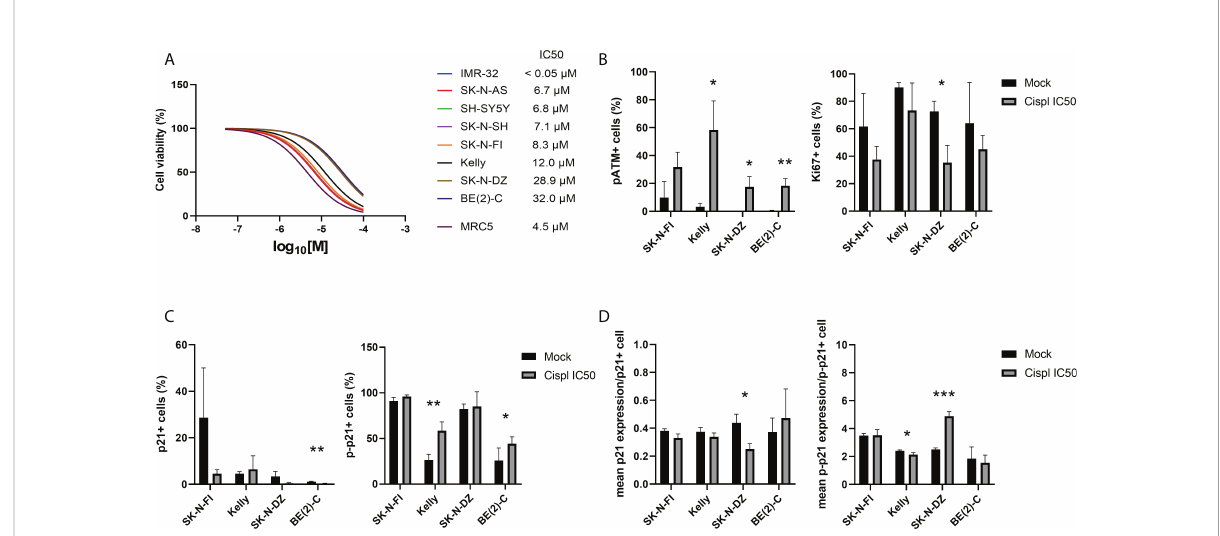
FIGURE 3 Immuno fl uorescence staining of p21, p-p21, pATM, and Ki67 in NB cell lines following treatment with cisplatin. (A) Dose – response curves for cell viability after 72 hours of cisplatin treatment in eight NB cell lines and the fi broblast cell line, MRC5. Cell viability was assessed using MTS-assay to determine the IC 50 values of cisplatin as a single agent. Concentration ranges, from 100 µM to 0.05 µM of cisplatin, was added. TP53 wt cell lines were in general more sensitive compared to the TP53 mut cell lines. n=3. (B) Analyzing the fraction of either pATM or Ki67 single positive cells following treatment with cisplatin for 24 hours at the corresponding IC 50 concentration for each of the cell lines. The fraction of pATM was increased in three out offour cell lines, and SK-N-DZ showed a reduction in the fraction of Ki67 positive cells following treatment. * = p<0.05, ** = p<0.01, not signi fi cant p>0.05, Student´s t-test. Mean ± SD, n=3. (C) Analyzing the fraction of either p21 or p-p21 single positive cells following treatment with cisplatin for 24 hours at the corresponding IC 50 concentration for each of the cell lines. BE(2)-C showed a decrease in the fraction of p21 positive cells, whereas Kelly and BE(2)-C showed an increase in the fraction of p-p21 positive cell. * = p<0.05, ** = p<0.01, not signi fi cant p>0.05, Student´s t-test. Mean ± SD, n=3-6. (D) Analyzing the mean intensity (mean fl uorescence in arbitrary units per cell ± SD) of either p21 or p-p21 single positive cells following treatment with cisplatin for 24 hours at the corresponding IC 50 concentration for each of the cell lines. SK-N-DZ showed a decrease in the mean intensity of p21 positive cells, whereas Kelly showed a decrease in the mean intensity of p-p21 positive cells, and SK-N-DZ showed an increase in the mean intensity of p-p21 positive cell. * = p<0.05, *** = p<0.001, not signi fi cant p>0.05. Student´s t-test. Mean ± SD,